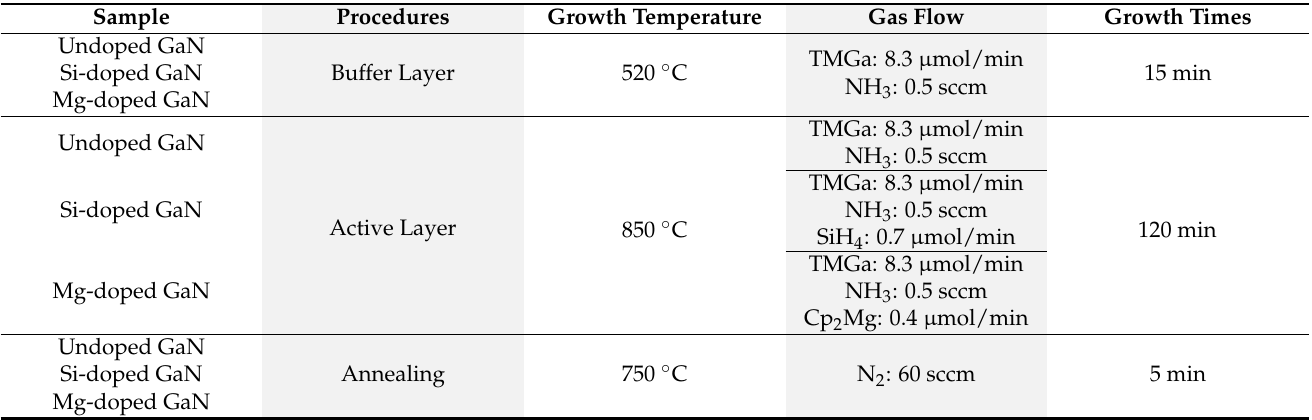
Table 1. Growth conditions of the undoped, Si-doped, and Mg-doped GaN thin films.